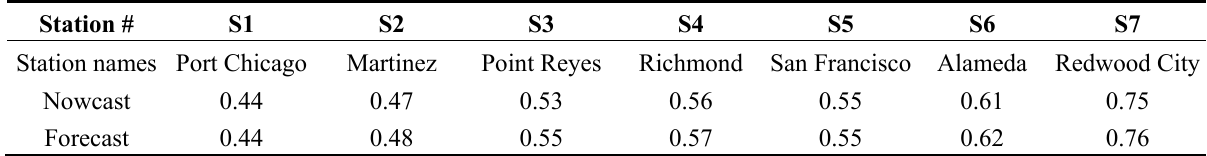
Table 14. Observed water level standard deviations (m) at selected stations in nowcast and forecast scenarios .